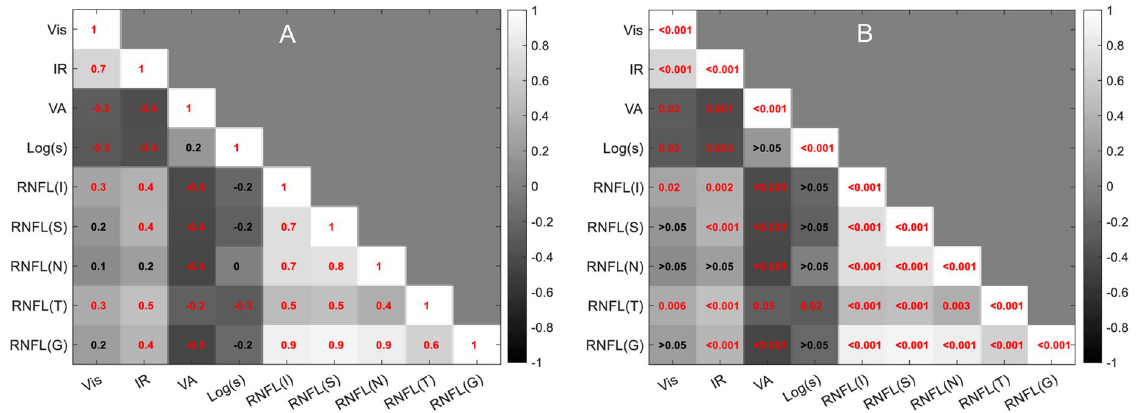
Figure 6. The correlation matrix for the study parameters and the corresponding Spearman’s rank correlation coefficient (ρ) ( A ) and p -values ( B ) with statistically significant correlations marked in red. The color scale bar indicates the ρ level. Vis = visible-light sensitivity, IR = IR-light sensitivity; log(s) = logarithm of the straylight parameter; RNFL = retinal nerve fiber layer, I = inferior; S = superior; N = nasal; T = temporal; G =